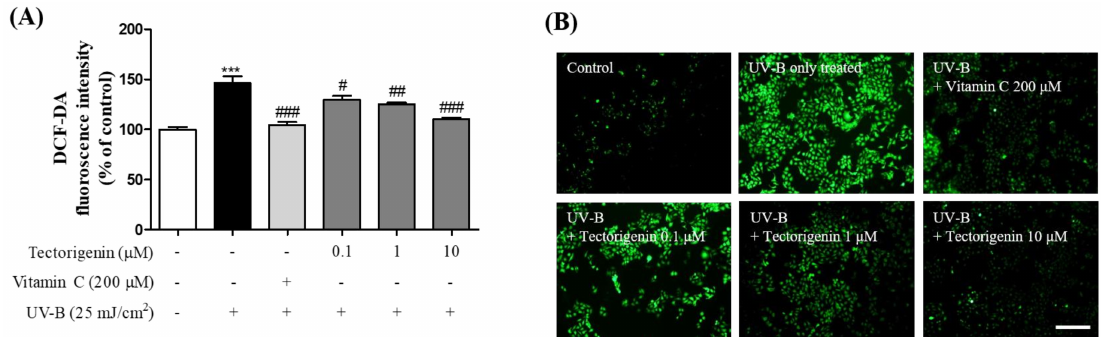
Figure 3. Inhibitory effects of tectorigenin on UV-B-induced generation of intracellular reactive oxygen species (ROS) in HaCaT cells. The cells were irradiated with 25 mJ/cm 2 UV-B and treated with tectorigenin at 0.1, 1, and 10 µ M or vitamin C at 200 µ M for 24 h ( A , B ). Intracellular ROS were measured by a DCFH-DA assay. Values are given as the mean ± SEM. *** p < 0.001 versus control group, # p < 0.05, ## p < 0.01, ### p < 0.001 versus UV-B-only treated group ( A ). Representative photomicrographs are shown. Scale bar = 50 µ m ( B